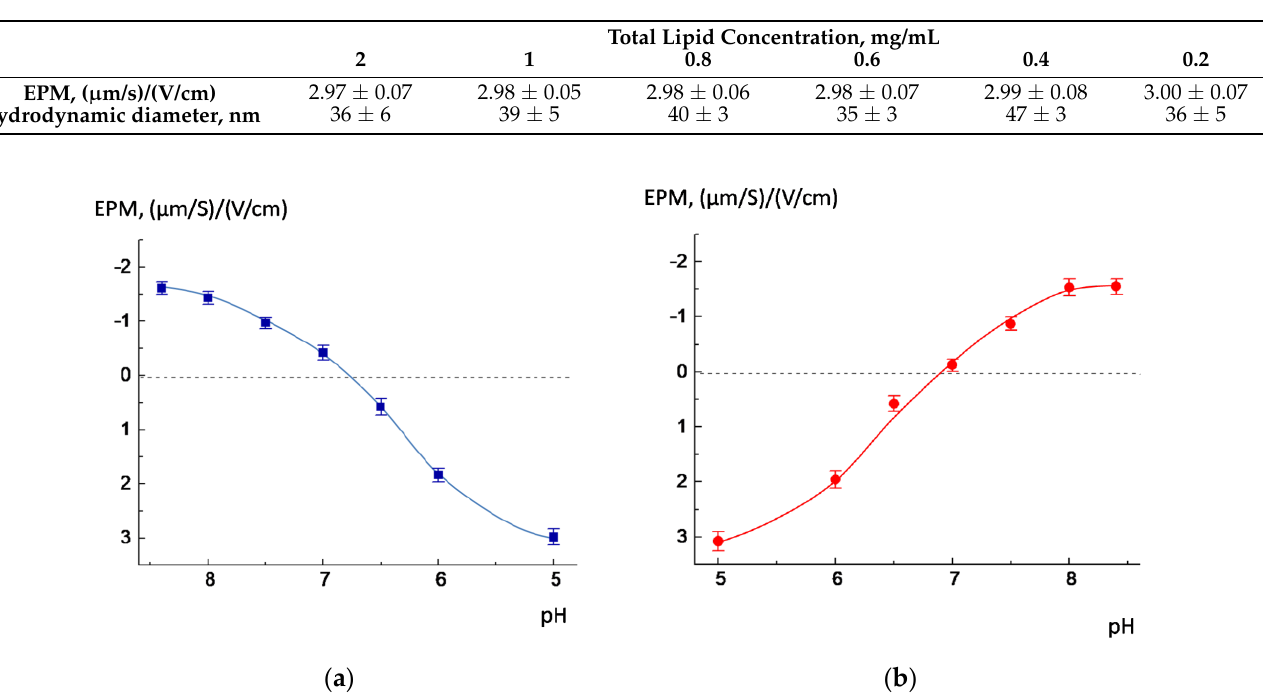
Table 3. EPM and particle size for POPC/AMS liposomes of different concentrations ( α = 0.1) obtained in a buffer with pH 5.0.